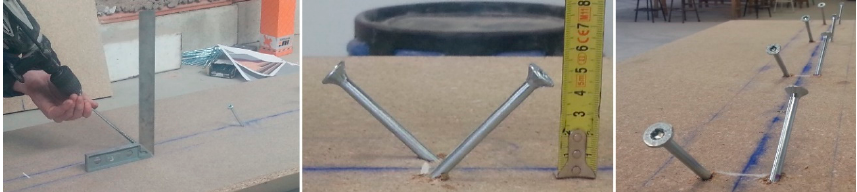
Figure 4. Placing the connectors.